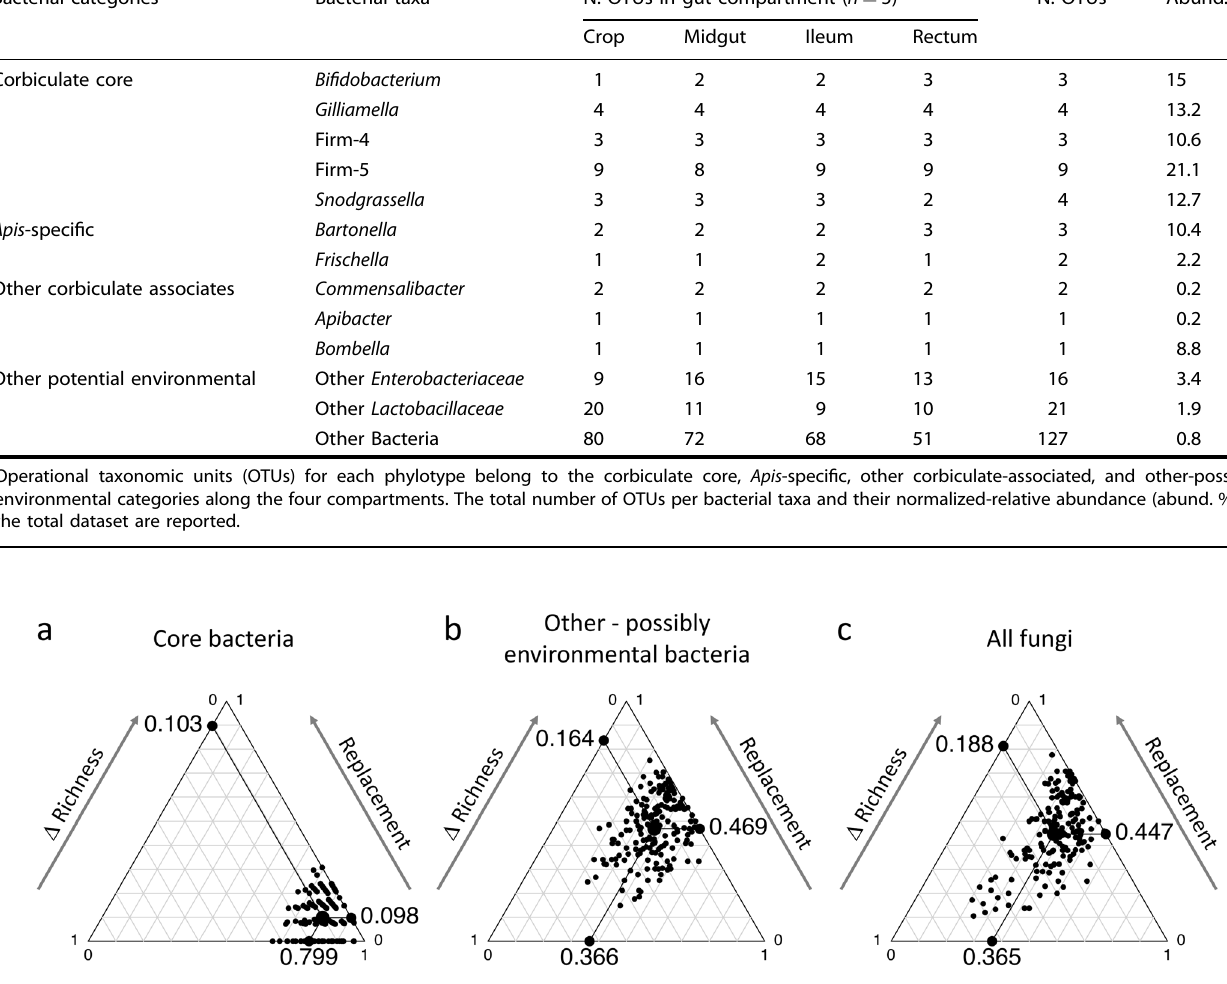
Table 1. Occurrence of bacterial taxa along the gut compartments of A. mellifera ligustica forager bees from Italy. Bacterial categories Bacterial taxa N. OTUs in gut compartment ( n = 5)